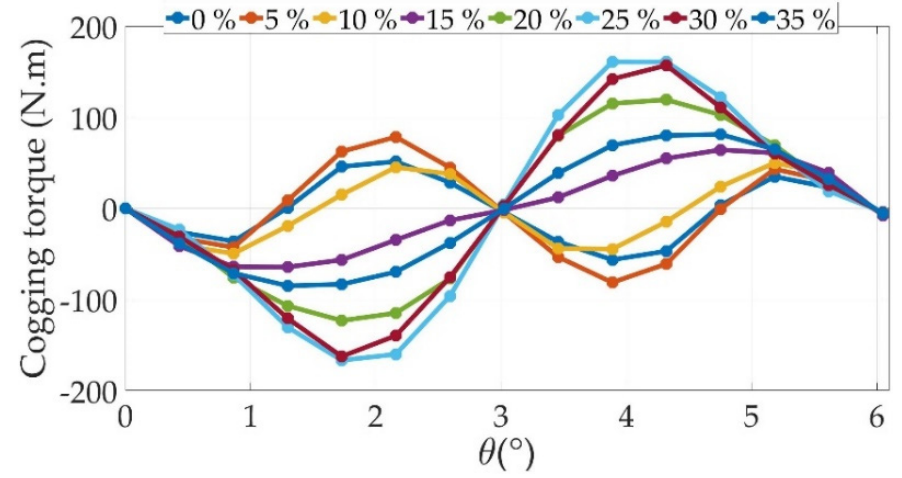
Figure 13. Cogging torque vs. rotor position for different ratios α ( β = 50%).